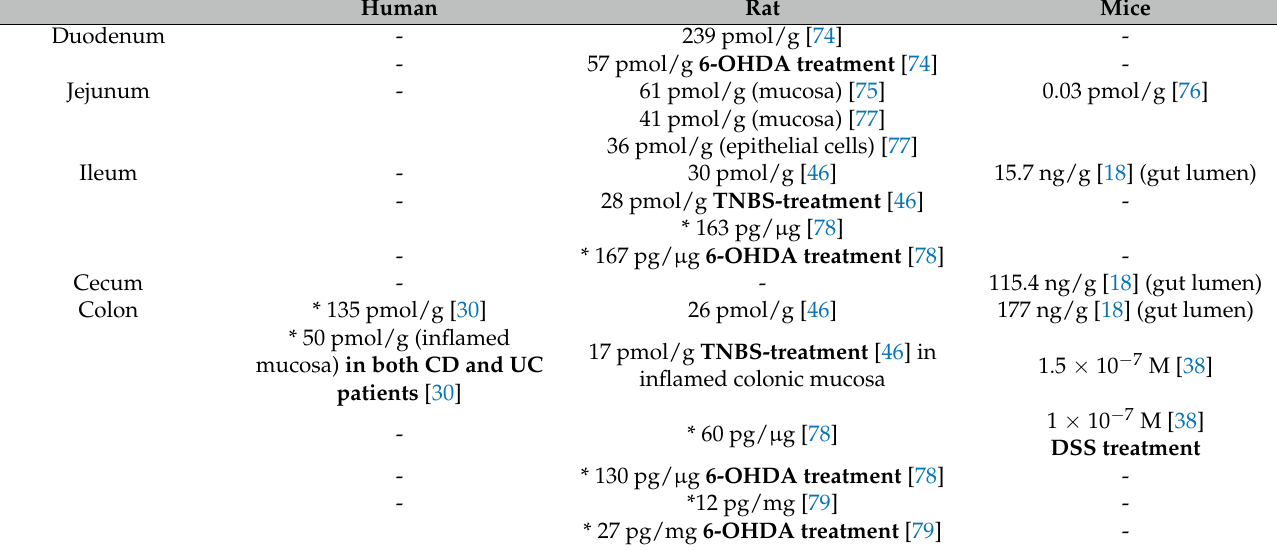
Table 5. Dopamine levels (original values) in healthy and diseased intestinal tissue samples of rodents and human subjects measured by HPLC. Abbreviations: 6-OHDA: 2,4,5-trihydroxyphenethylamine; TNBS:2,4,6-trinitrobenzene sulfonic acid; CD: Crohn’s disease, UC: ulcerative colitis; * estimates obtained from graphs because no exact values were given in the